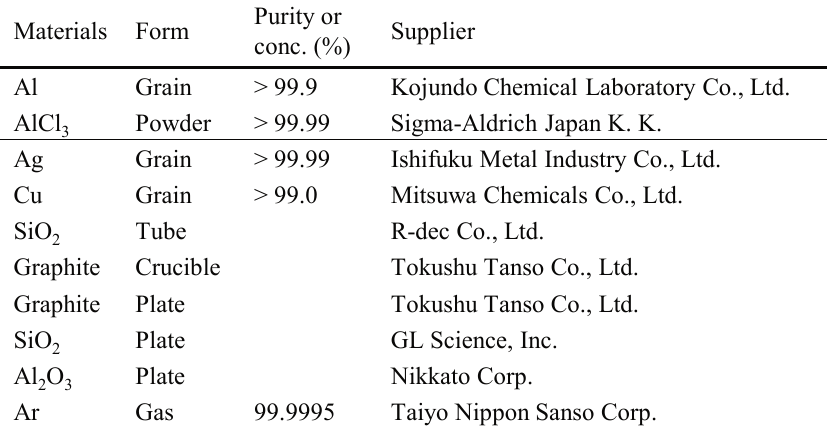
Table 3. Materials used in this study.